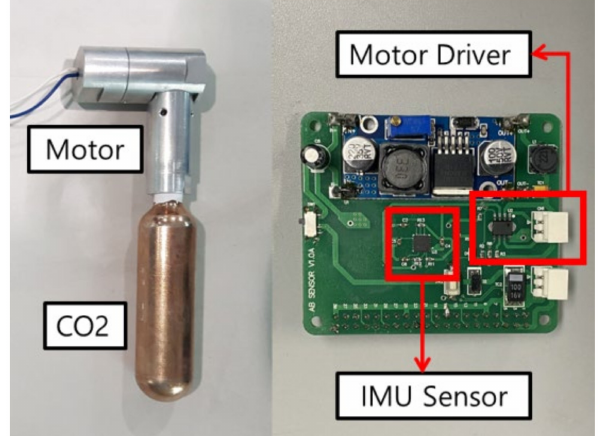
Figure 4. Measuring- and driving-part